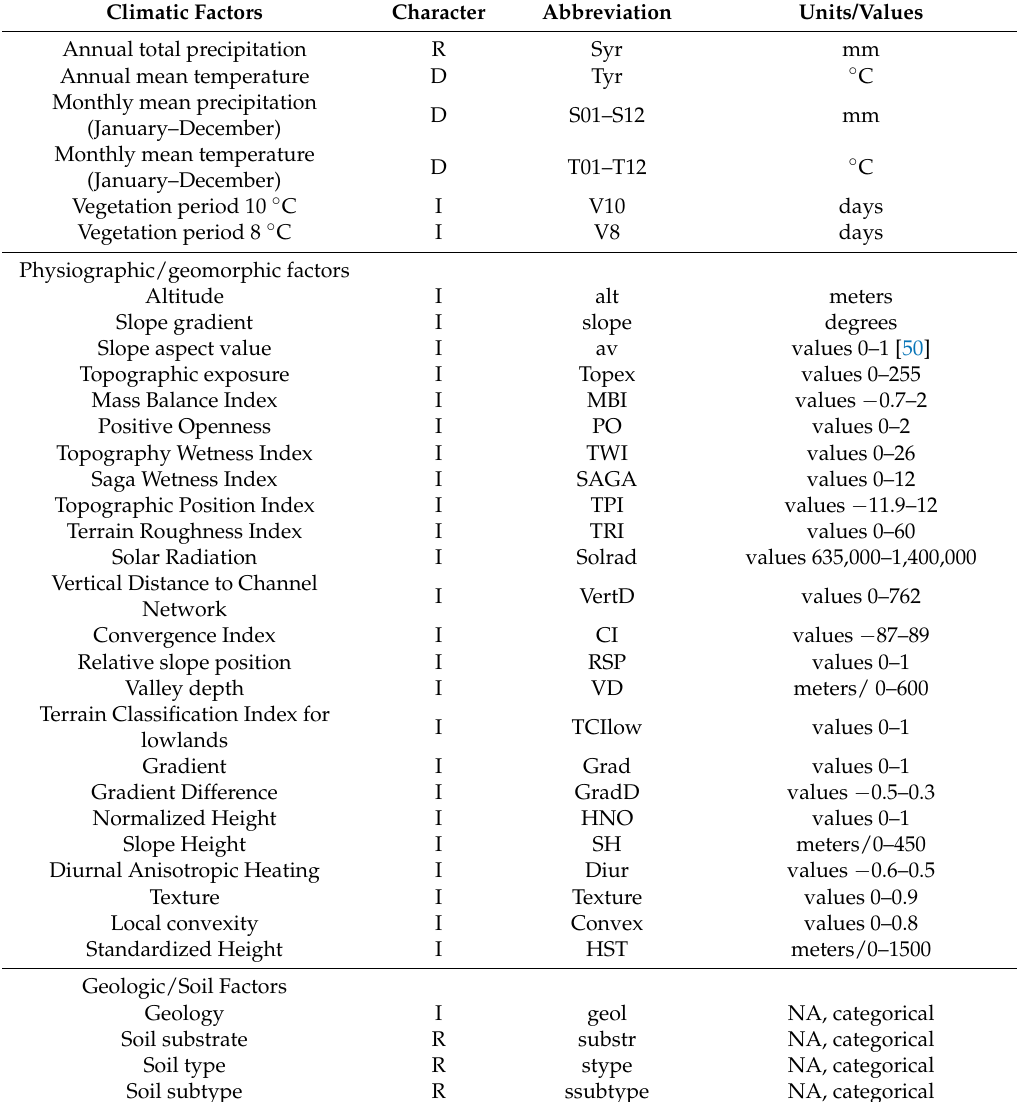
Table 1. Types of environmental factors used in the study